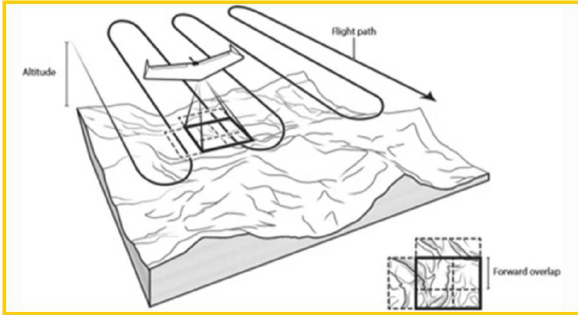
Figure 3. UAV-photogrammetry mapping (F, 2011)